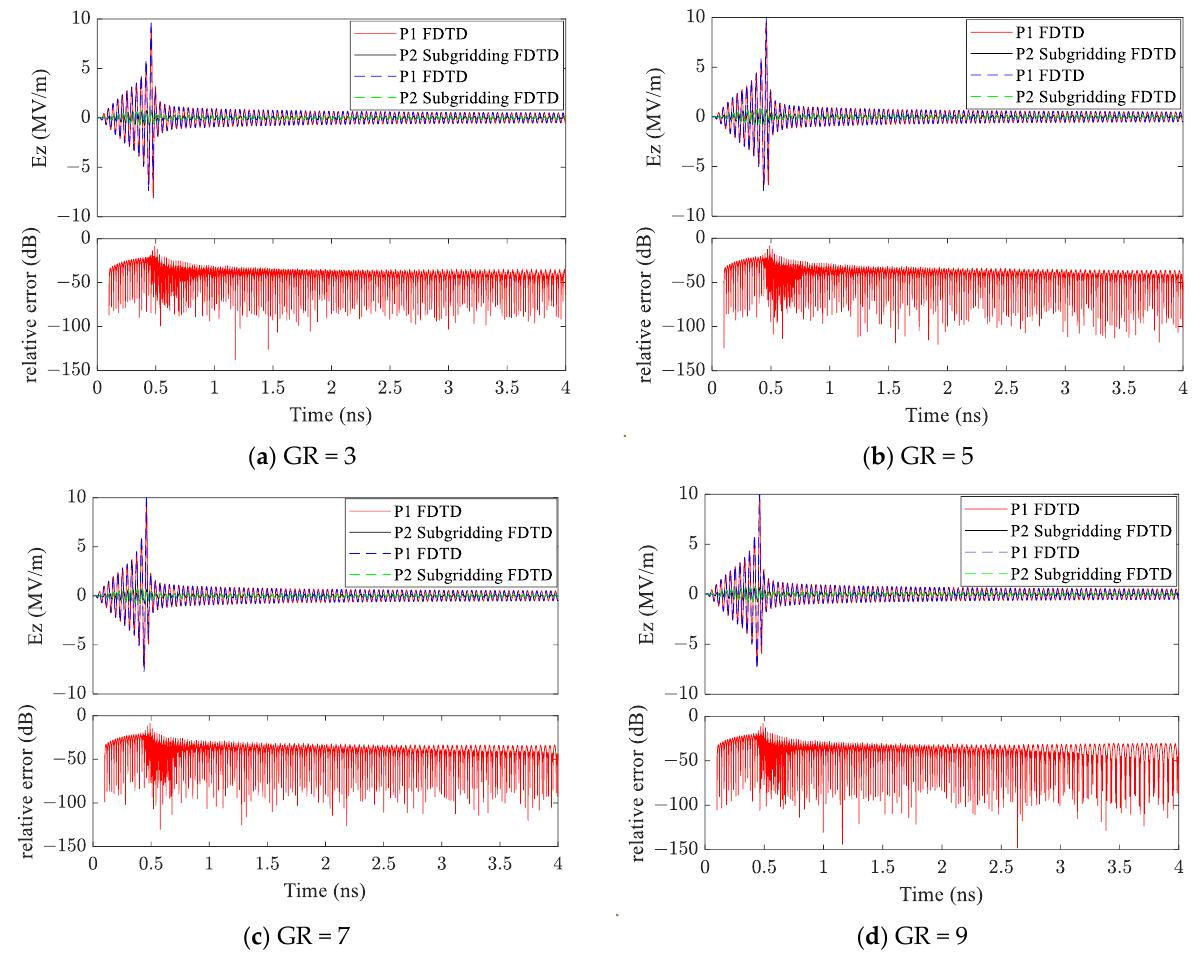
E component recorded at P1 and P2 for different GR. Figure 7. Temporal response of the Figure 7. Temporal response of the E z component recorded at P1 and P2 for different z